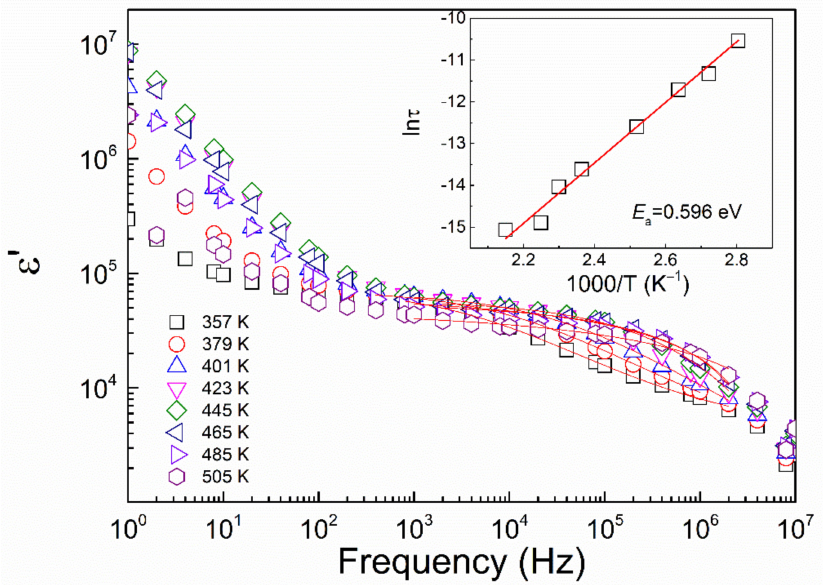
Figure 8. Frequency dependence of high- T dielectric constant in La 2/3 Cu 3 Ti 4 O 12 ceramics from 357 K to 505 K. Experimental data are represented by solid symbols which are linearly fitted by Equation (1). Inset represents the linear dependence of the relaxation time τ vs. temperature.